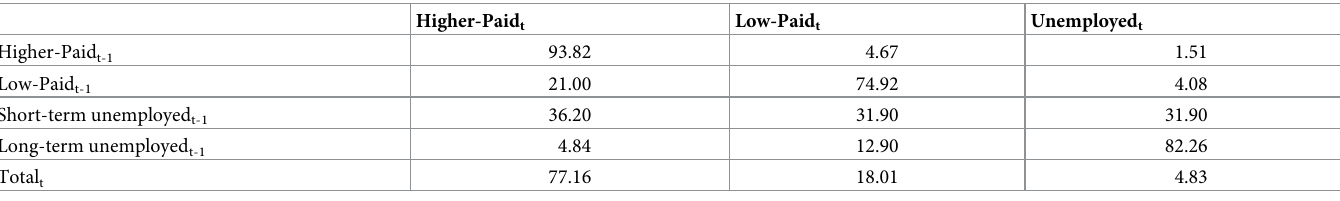
Table 2. Persistence and change in labour market positions (transition